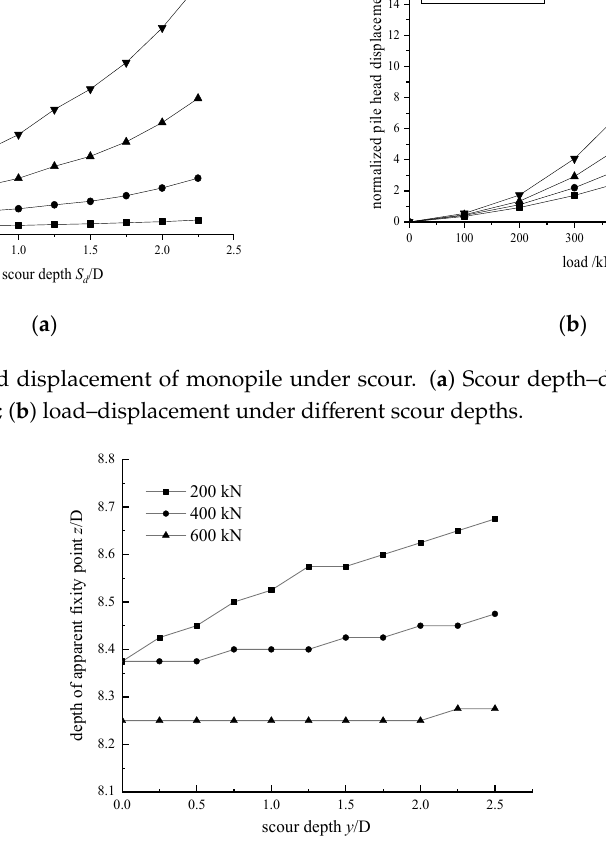
Figure 15. Scour depth–apparent fixity depth under different load levels.